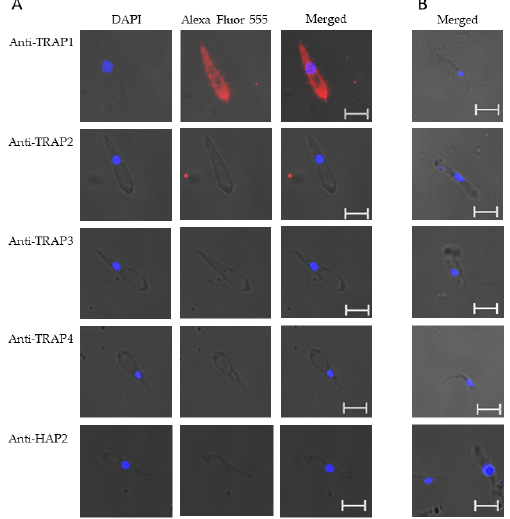
Figure 4. Babesia bovis kinetes expressed TRAP1 protein as determined by a fixed immunofluorescence assay incubated with anti-TRAP1, 2, 3, 4, or HAP2. Panels are ( A ) immune and ( B ) pre-immune rabbit serum. Blue indicates DAPI stained DNA and red indicates anti-rabbit IgG Alexa Fluor 555 reactivity. Scale bar: 5 µm. Using live IFA, we demonstrated that TRAP2, 3, and 4 were surface-exposed proteins on both blood (Figure 5A) and in vitro induced sexual stages (Figure 6A). Matching pre- immune rabbit sera showed no antibody reactivity with B. bovis blood (Figure 5B) or in vitro induced sexual stages (Figure 6B). We were unable to determine if TRAP proteins were surface exposed due to the lack of methods to isolate intact live kinetes.